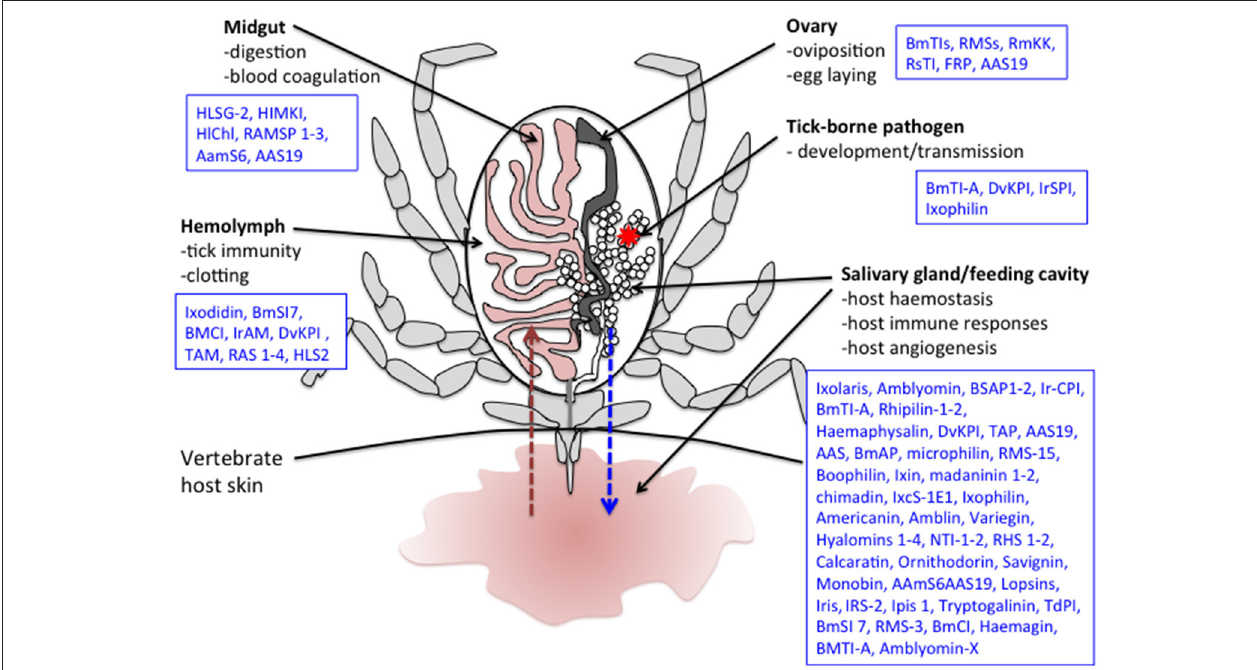
FIGURE 2 | Schematic representation of a tick during feeding. Several tick serine protease inhibitors identified in different tick species and implicated in both tick biology/physiology and modulation of the vertebrate host responses to tick bite are also indicated. The red arrow represents blood absorption. The blue arrow represents saliva injection. The red star corresponds to a tick-borne pathogen. Note that only half of the digestive tract and a single salivary gland and ovary are represented here. Boophilus microplus subtilisin inhibitors (BmSI); Boophilus microplus Chymotrypsin inhibitor (BmCI); Ixodes ricinus alpha macroglobuline (IrAM); Dermacentor variabilis Kunitz protease inhibitor (DvKPI); Tick α -Macroglobulin (TAM); Boophilus microplus trypsin inhibitor (BmTIs); R. appendiculatus Serpins (RAS); H. longicornis serine proteinase genes (HLSG); Haemaphysalis longicornis midgut Kunitz-type inhibitor (HlMKI); Haemaphysalis longicornis serpin (HLS); Haemaphysalis longicornis chymotrypsin inhibition (HlChI); R. appendiculatus Midgut Serine proteinases (RAMSP); R.B. microplus Serpin (RMS); Amblyomma americanum serpin 6 (AamS6); Amblyomma americanum serpin 19 (AAS19); R.B. microplus Kunitz kallikrein inhibitor (RmKK); I. ricinus contact phase inhibitor (IrCPI); Tick Anticoagulant Protein (TAP); Boophilus microplus Anticoagulant Protein (BmAP); B. microplus gut thrombin inhibitor ( BmGTI ); Nymph thrombin inhibitor (NTI); Rhipicephalus haemaphysaloides serpin (RHS); I. ricinus immunosuppressive (Iris); I. ricinus serpin (IRS); Ixodes persulcatus immunosuppressive (Ipis); I. ricinus serine protease inhibitor (IrSPI); R. microplus Larval Trypsin Inhibitor